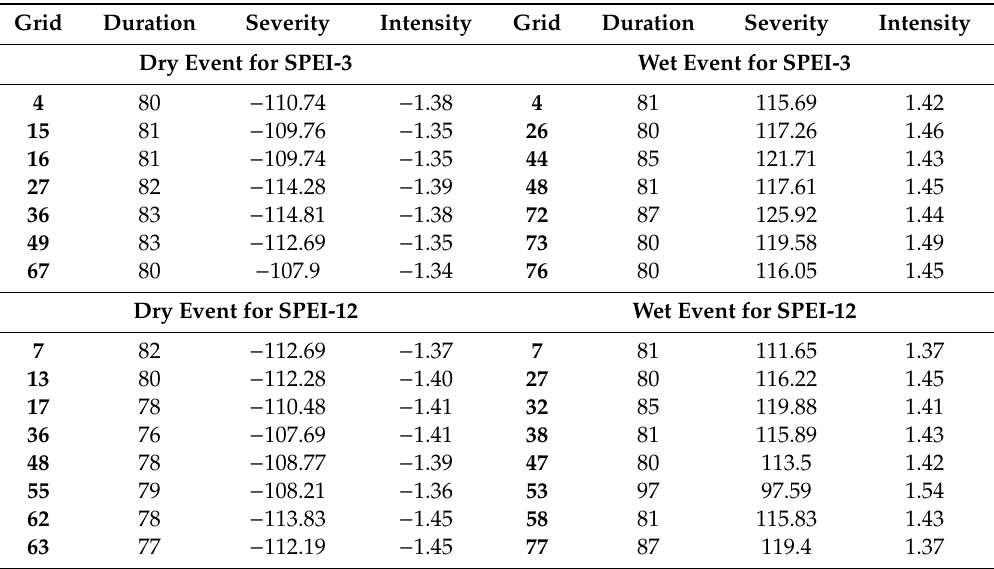
Table 3. The duration, severity and intensity of occurrence of some of the major dry and wet events (SPEI ≤ − 1 SPEI ≥ + 1) over each grid cell in Kenya,